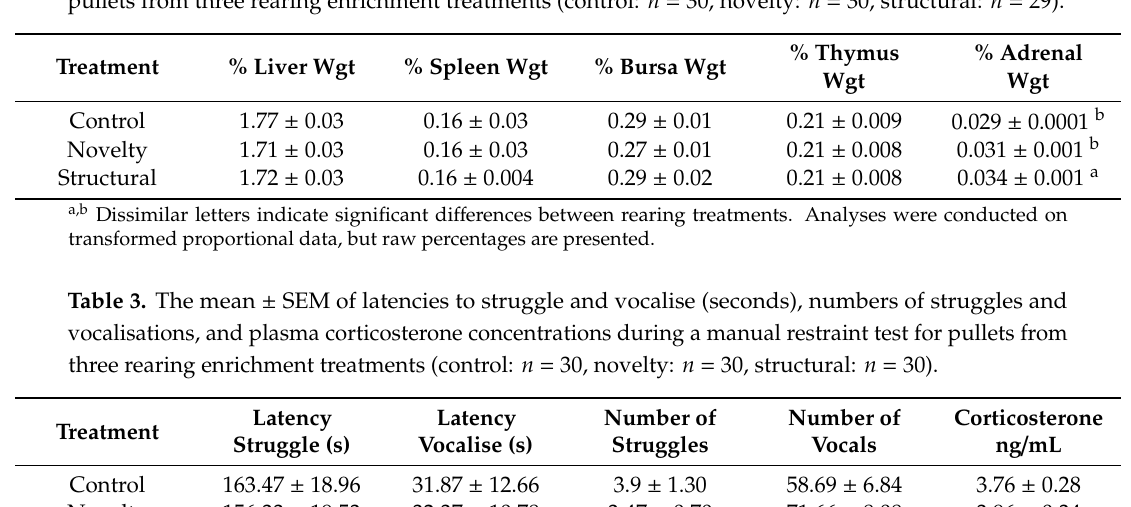
Table 2. The mean percentage weights ( ± SEM) of organs relative to live body weight from 16-week-old pullets from three rearing enrichment treatments (control: n = 30, novelty: n = 30, structural: n = 29).